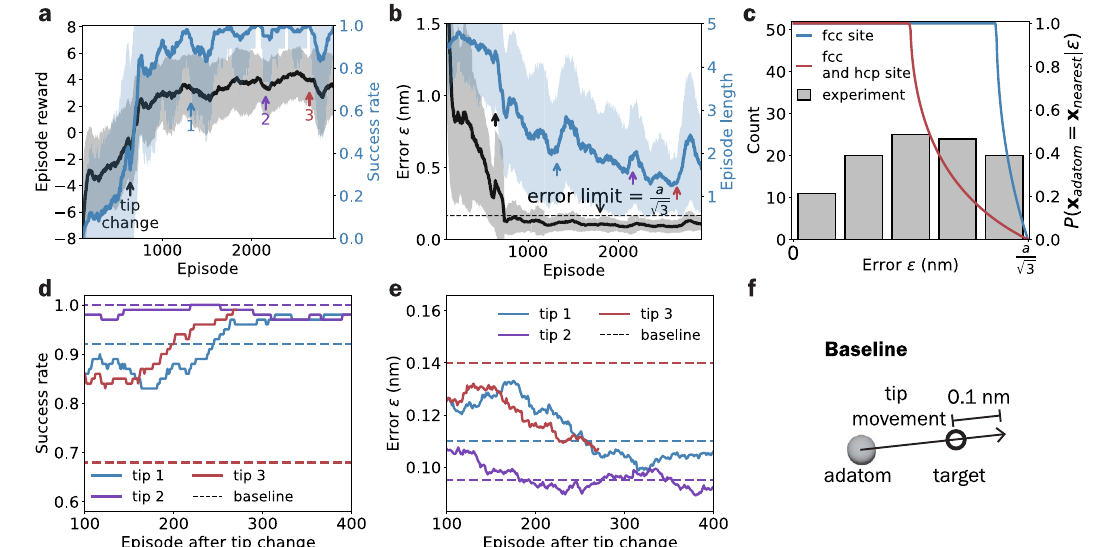
atomsareplacedatthenearestsite~93%(onlyfccsites)and~61%(bothfccandhcp sites)ofthetime. d , e TheDRLagent,whichiscontinuallytrained,andthebaseline are compared under three tip conditions that resulted from the tip changes indi- cated in a , b . The baseline uses bias V =10mV, conductance G =6 μ A/V, and tip movements illustrated in f . Under the three tip conditions, the baseline manip- ulation parameters lead to varying performances. In contrast, DRL always con- verges to near-optimal performances after suf fi cient continued training. f In the baseline manipulation parameter, the tip moves from the adatom position to the target position extended by